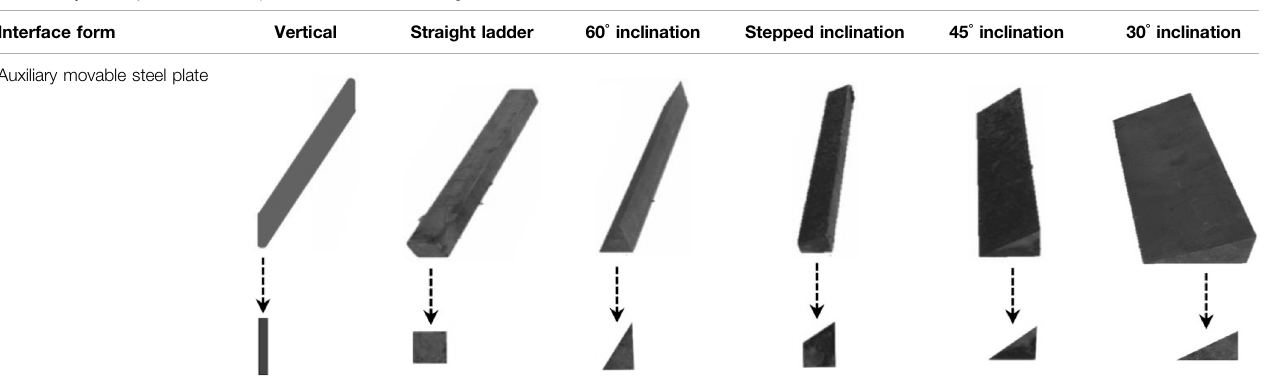
Frontiers in Materials |